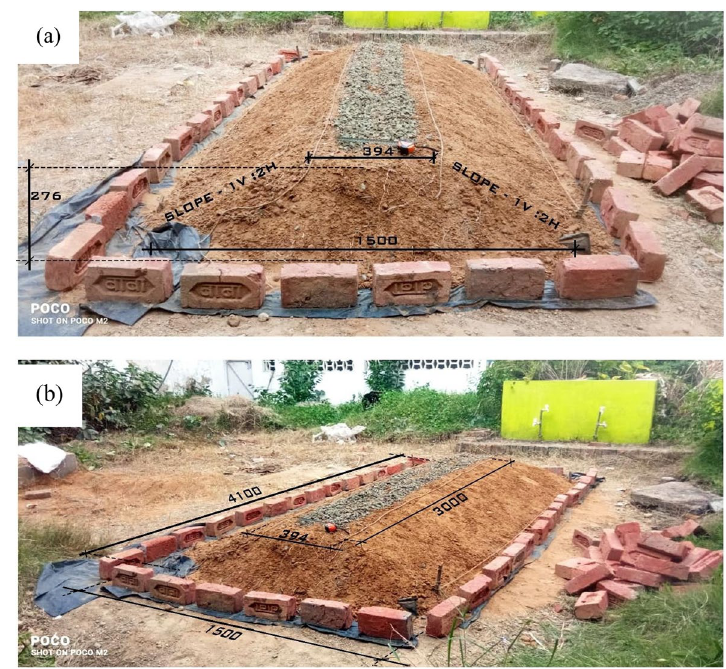
Fig. 8 a, b Cross-sectional details of fully constructed embankment